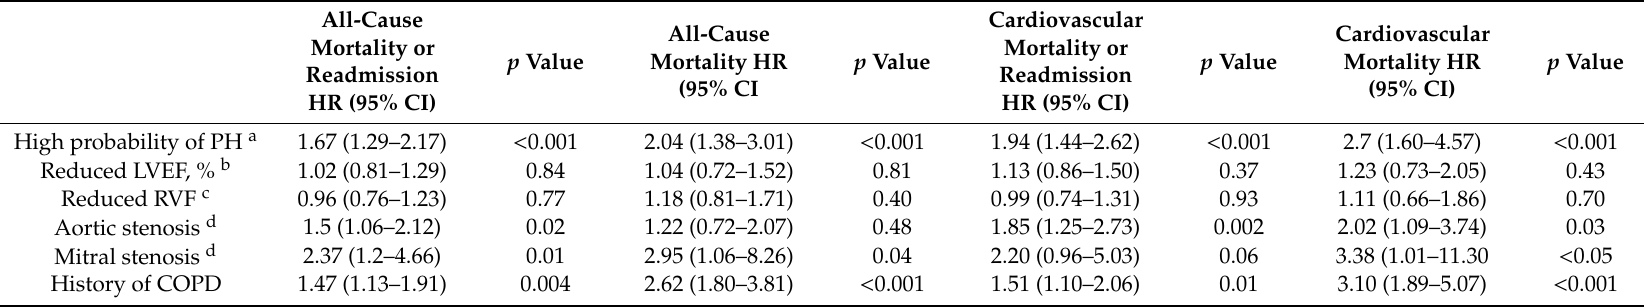
Table 4. Adjusted association of the probability of pulmonary hypertension, left ventricular ejection fraction, and right ventricular function with primary and secondary